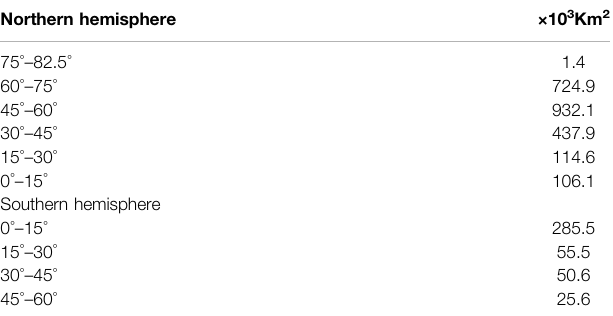
TABLE 1 | Global freshwater surface area in each 15 ° latitude bandwidth is shown in this table. Northern hemisphere